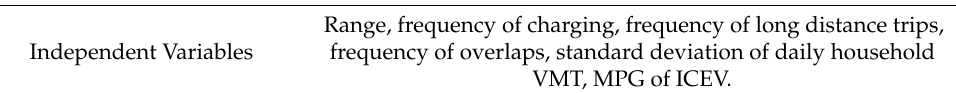
Table 1. Variables in our compiled dataset. eVMT, VMT of the PEV, VMT of the household, utility factor of Dependent Variables the PHEV, utility factor of the household, household fuel consumption. Range, frequency of charging, frequency of long distance trips, Independent Variables frequency of overlaps, standard deviation of daily